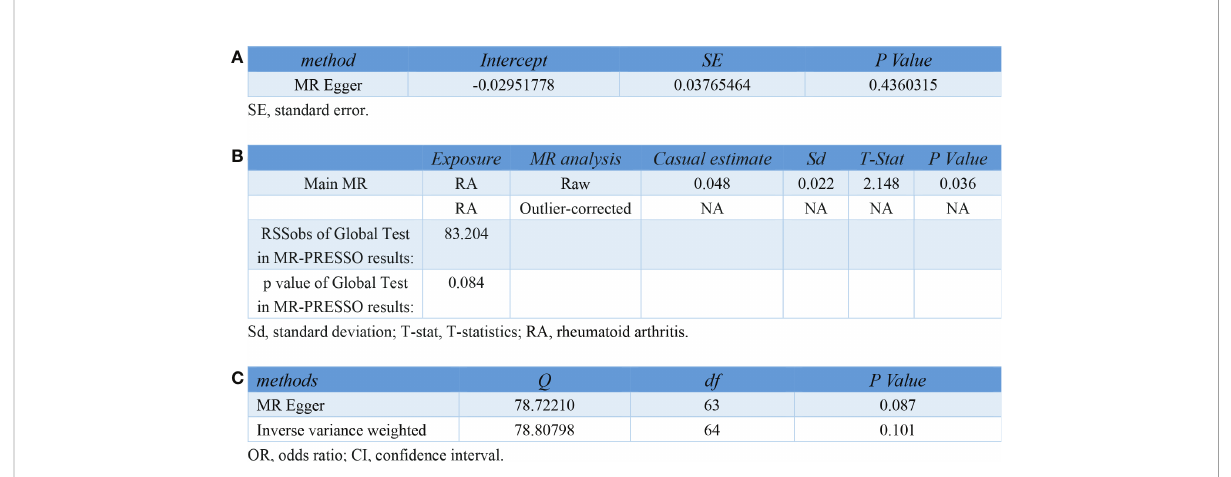
FIGURE 3 Pleiotropy and heterogeneity testing in sensitivity analyses of IVs for RA. (A) Pleiotropy testing using MR Egger regression (B) Pleiotropy testing using MR-PRESSO. (C) Heterogeneity testing using the Cochrane Q statistic. IV, instrument variant; RA, rheumatoid arthritis; MR, mendelian randomization; MR-PRESSO, mendelian randomization pleiotropy residual sum and